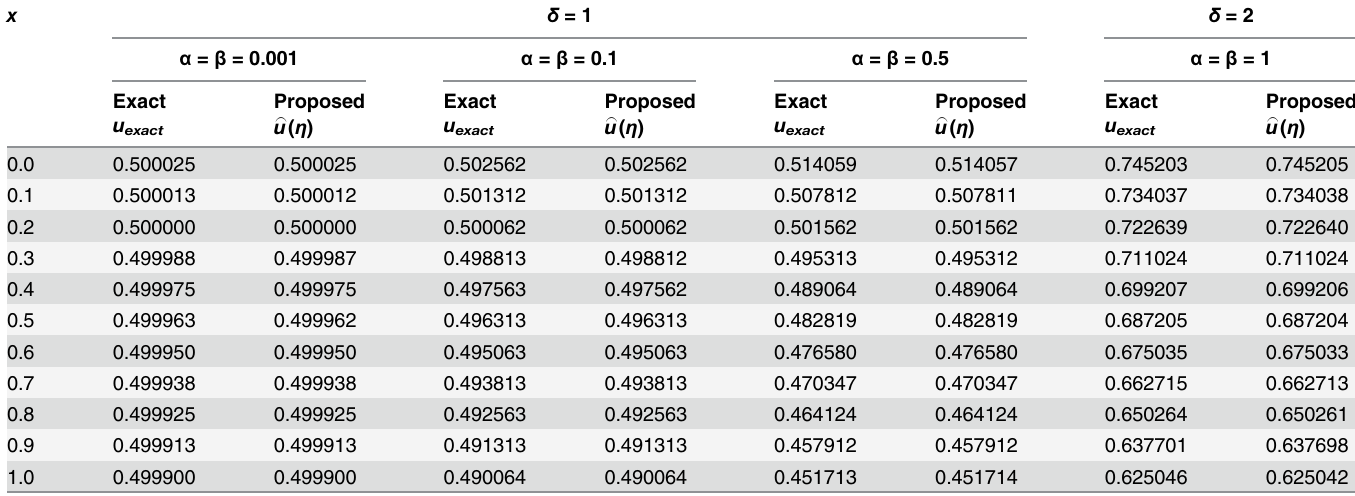
Table 3. Numerical solutions of generalized Burgers 0 -Fisher equation by the proposed scheme for different values of α , β , δ and comparison with exact solutions for time t = 0.1. x δ = 1 δ = 2 α = β = 0.001